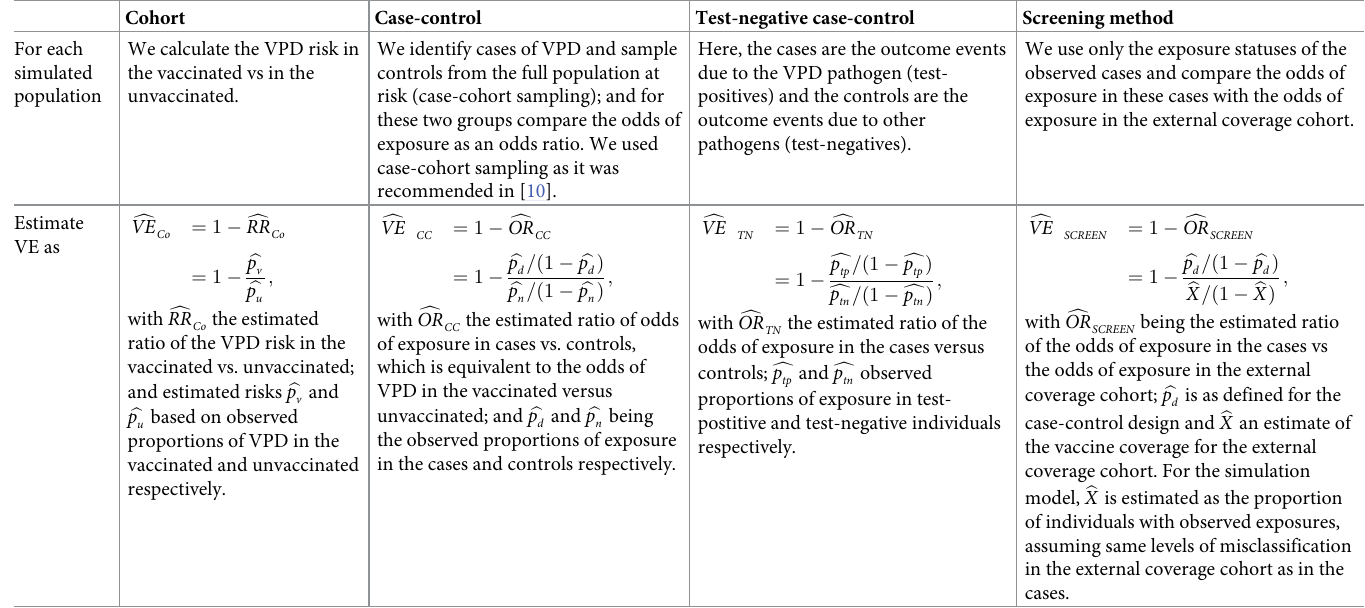
Table 1. Estimation of vaccine effectiveness (VE) for the cohort, case-control, test- negative case-control and case-coverage (screening method) design.